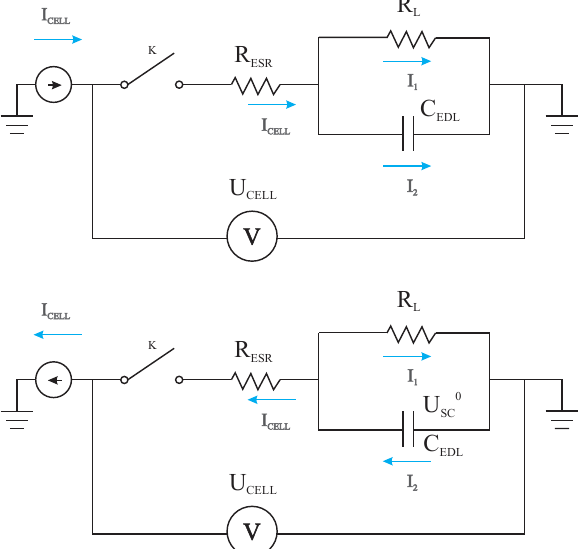
Figure 2. Electric circuits containing the canonic equivalent circuit model representing the electrochemical behavior of electric double layer capacitors during the charging and discharging processes carried out at constant current. Definitions: I cell is the constant current applied; R ESR is the equivalent series resistance; R L is the leakage resistance; C EDL represents the equivalent capacitance of the symmetric coin cell; U cell is the overall cell voltage and U SC0 is the voltage across the C EDL when the capacitor is fully charged.